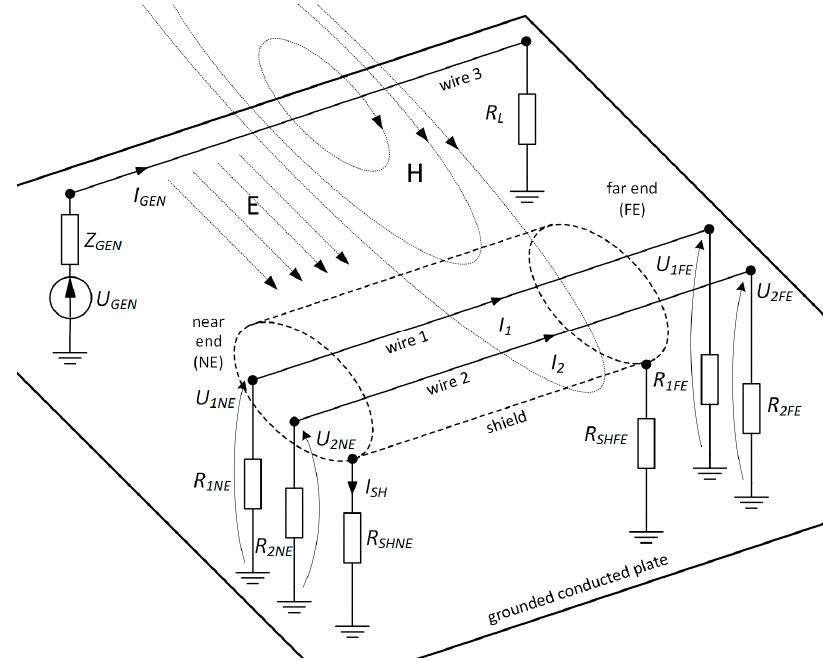
Figure 7. The simplified electrical diagram of the tested system.